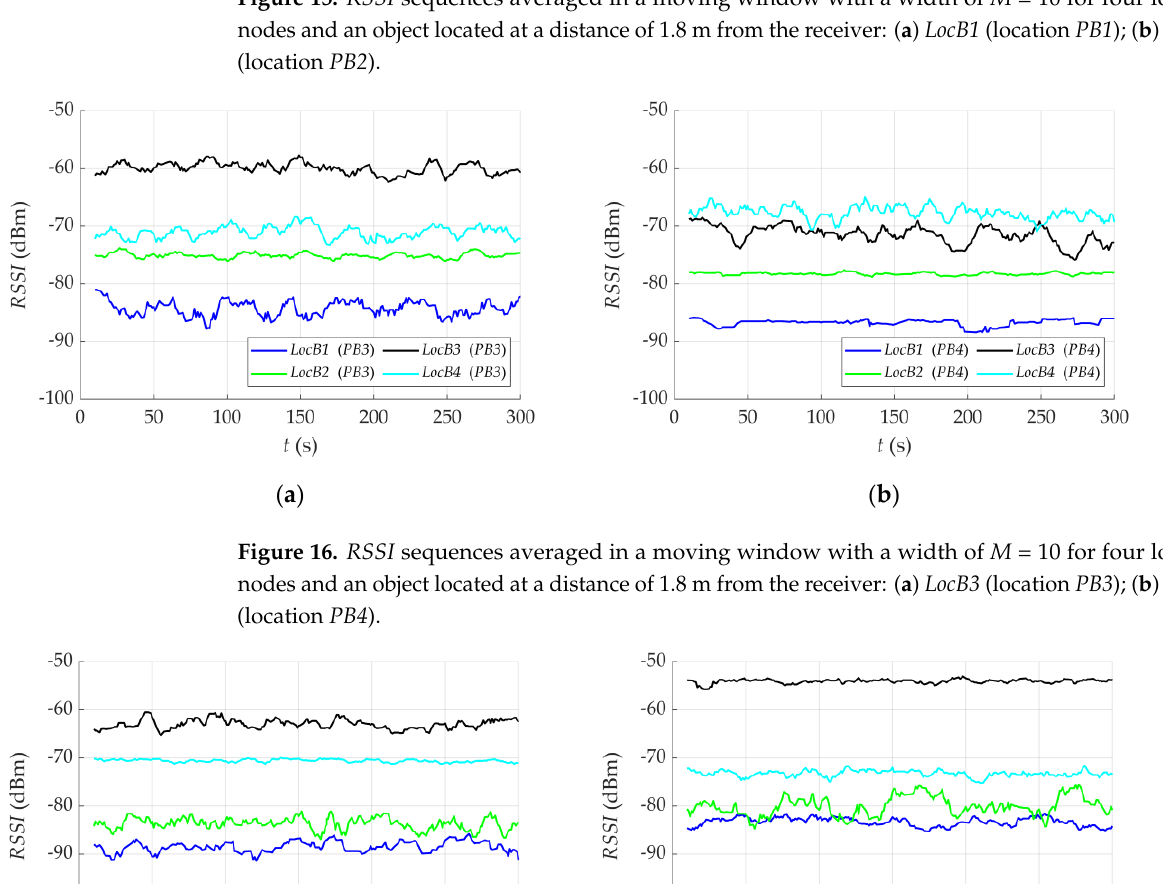
Figure 18. RSSI sequences averaged in a moving window with a width of M = 10 for four locator nodes and an object placed in front of the LocB3 receiver at a distance of 0.5 m (location PB7 ). As it results from the analysis of Figures 15 – 18, the use of an averaging filter with a window width adequately chosen due to the surrounding conditions allows in practically all cases to clearly indicate the locator node closest to the object. Only in the case of the locator node placed in the vicinity of the metal frame of the elevator shaft and the metal railing ( LocB2 ), there are occasional erroneous detections (shown in Figure 15b). These errors resulted in the selection of locator nodes that are 5.5 m and approx. 10 m away. The window width M is an important parameter, the increase in which, on the one hand, reduces the variance of the estimates, but on the other hand, deteriorates their dynamics. For this reason, this parameter should be selected optimally, taking into account the conditions under which the locator node works. The rules for the selection of the M value can be formulated on the basis of the probability of each locator node detection, the closest one to a given object location and the neighboring ones, depending on the width M of the moving window. Such characteristics for object locations PB1 – PB6 are presented in Figures 19 – 21.